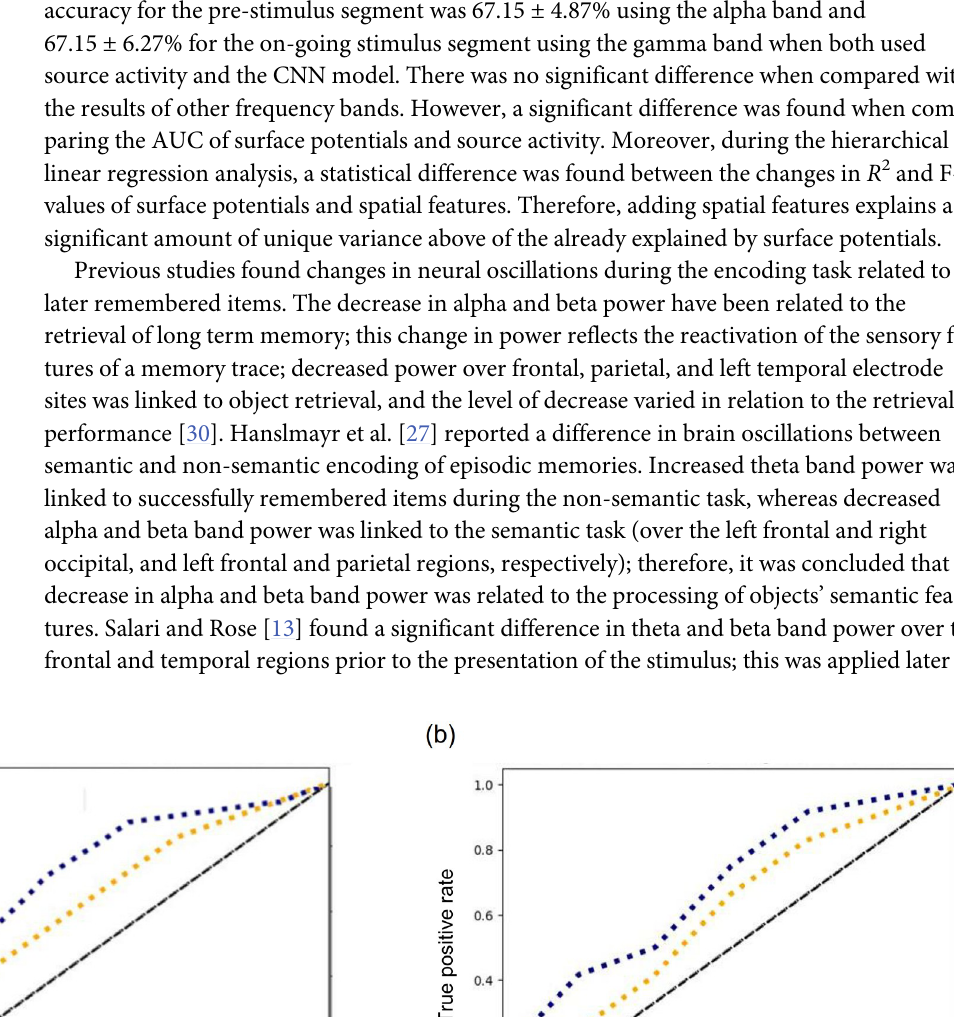
PLOS ONE | https://doi.org/10.1371/journal.pone.0274101 September 8,